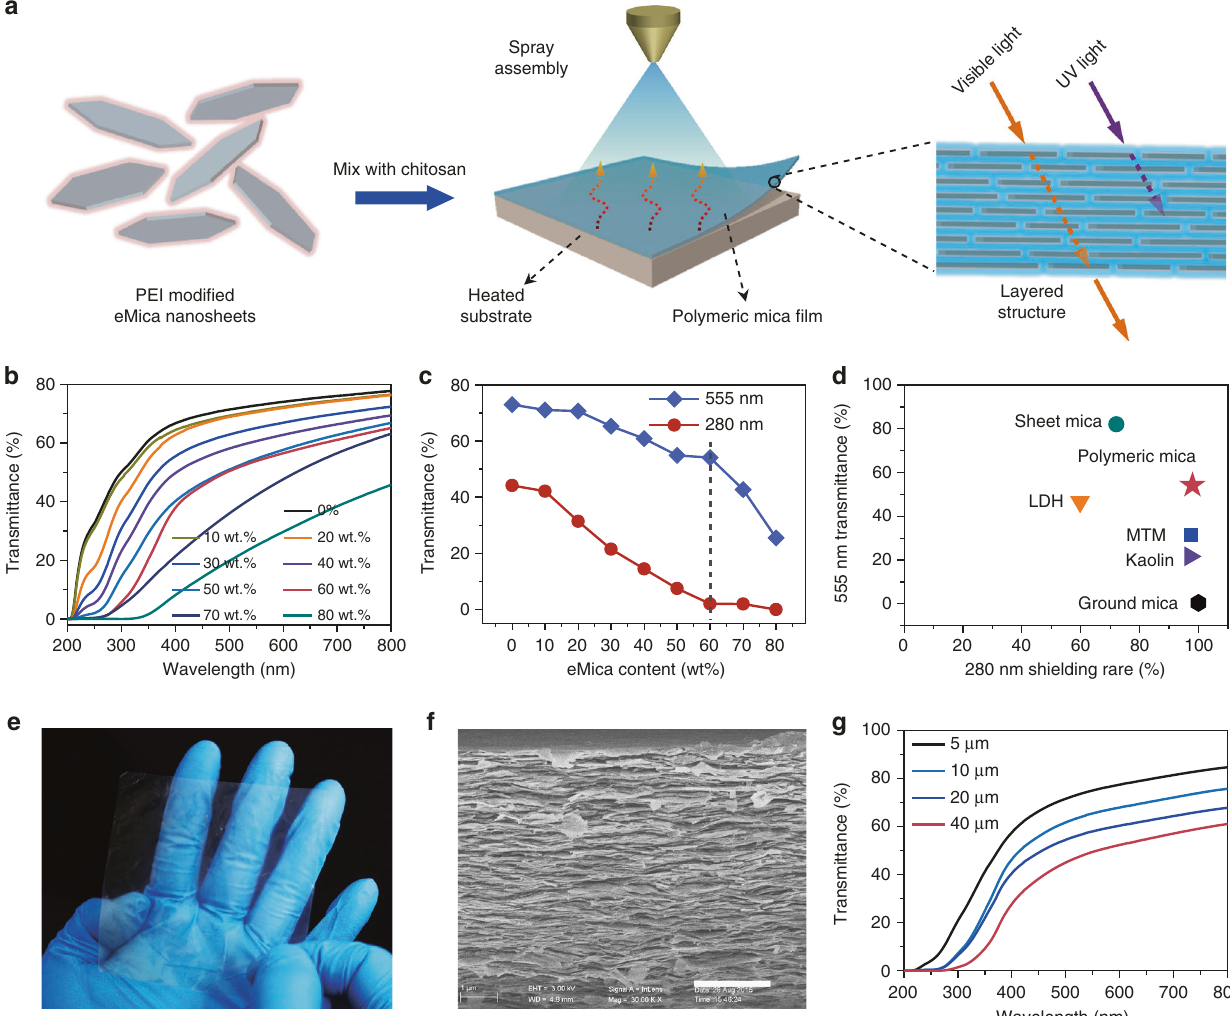
Fig. 3 Optical performance of polymeric mica fi lms. a Schematic illustration displaying that PEI-eMica nanosheets are mixed with CS solution, which is further assembled into transparent and strong polymeric mica fi lms by a spray-coating method. b UV-visible transmittances of ~25 µ m thick polymeric mica fi lms with different eMica nanosheet content. c Transmittances of polymeric mica fi lms at 555 nm (visible region) and 280 nm (UV region) with different eMica nanosheet content. d Comparison of the transmittance at 555 nm and shielding rate at 280 nm of 60 wt.% polymeric mica fi lm, sheet mica,